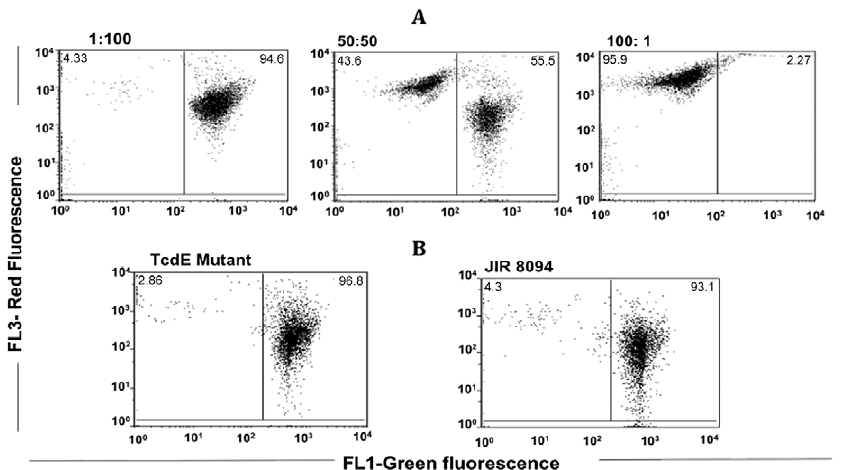
Figure 5. FACS analysis of C.difficile cells for membrane permeability through propidium iodide (PI) and SYTO staining. A. The viability standard samples containing the heat killed and actively growing C. difficile cells at 1/100, 50/50 and 100/1 ratio, respectively. B. The tcdE mutant and the parent JIR8094 cells collected from the overnight (16 h) cultures, were subjected to FACS analysis following propidium iodide (PI) and SYTO